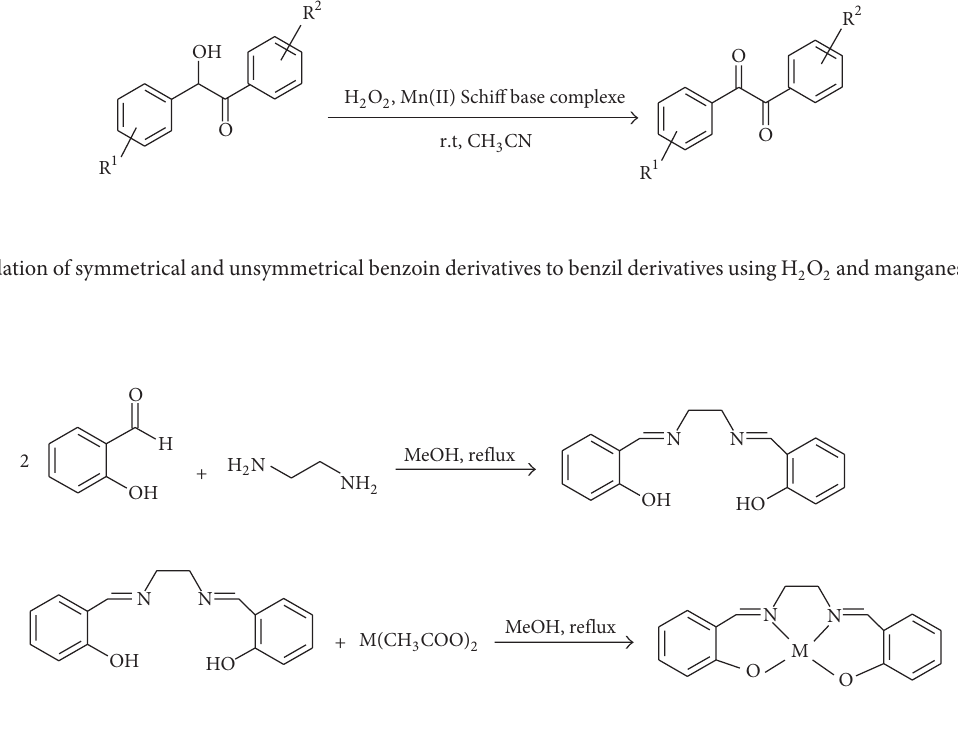
S 2: Preparation of the Schiff base complexes of metal(II) as